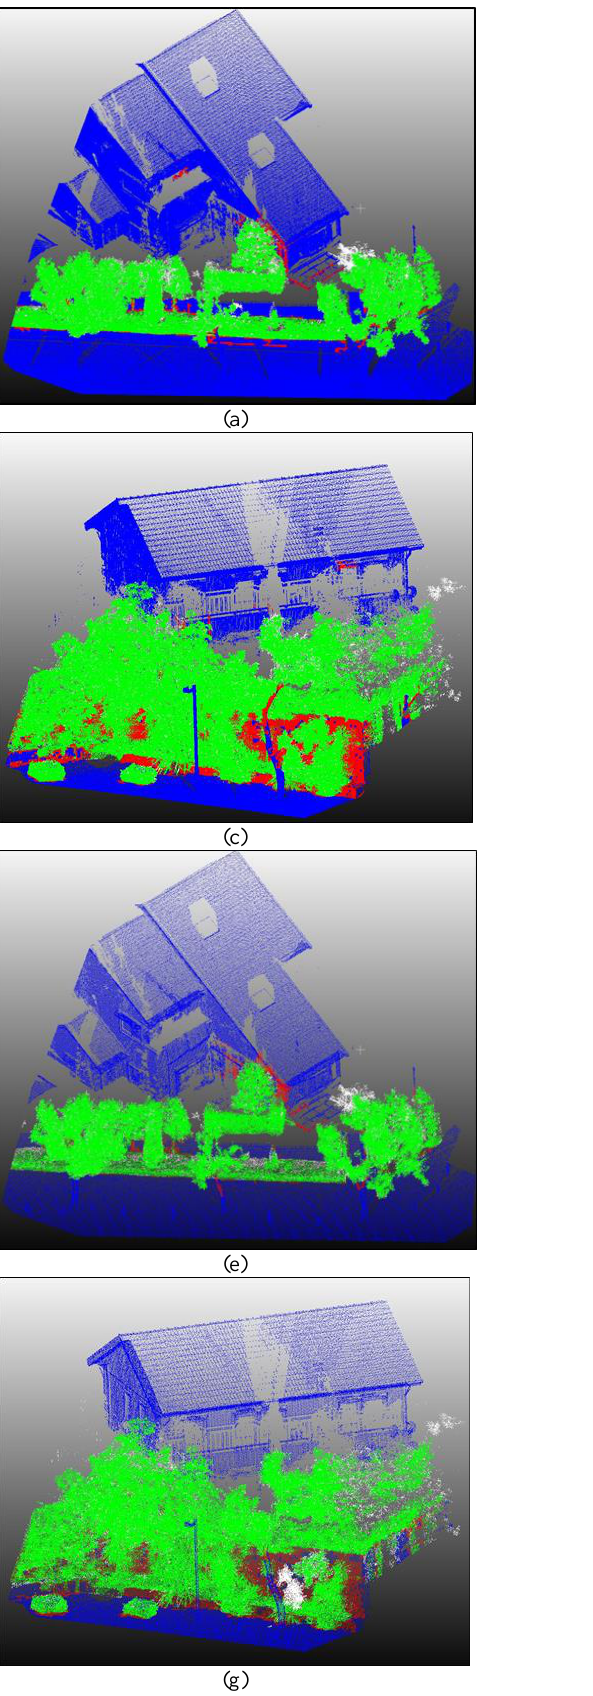
Figure 9. Results of vegetation extracted by the proposed method. (a), (b) Results from Data 1, (c), (d) results from Data 2, (e), (f) results from Data 3, and (g), (h) results from Data